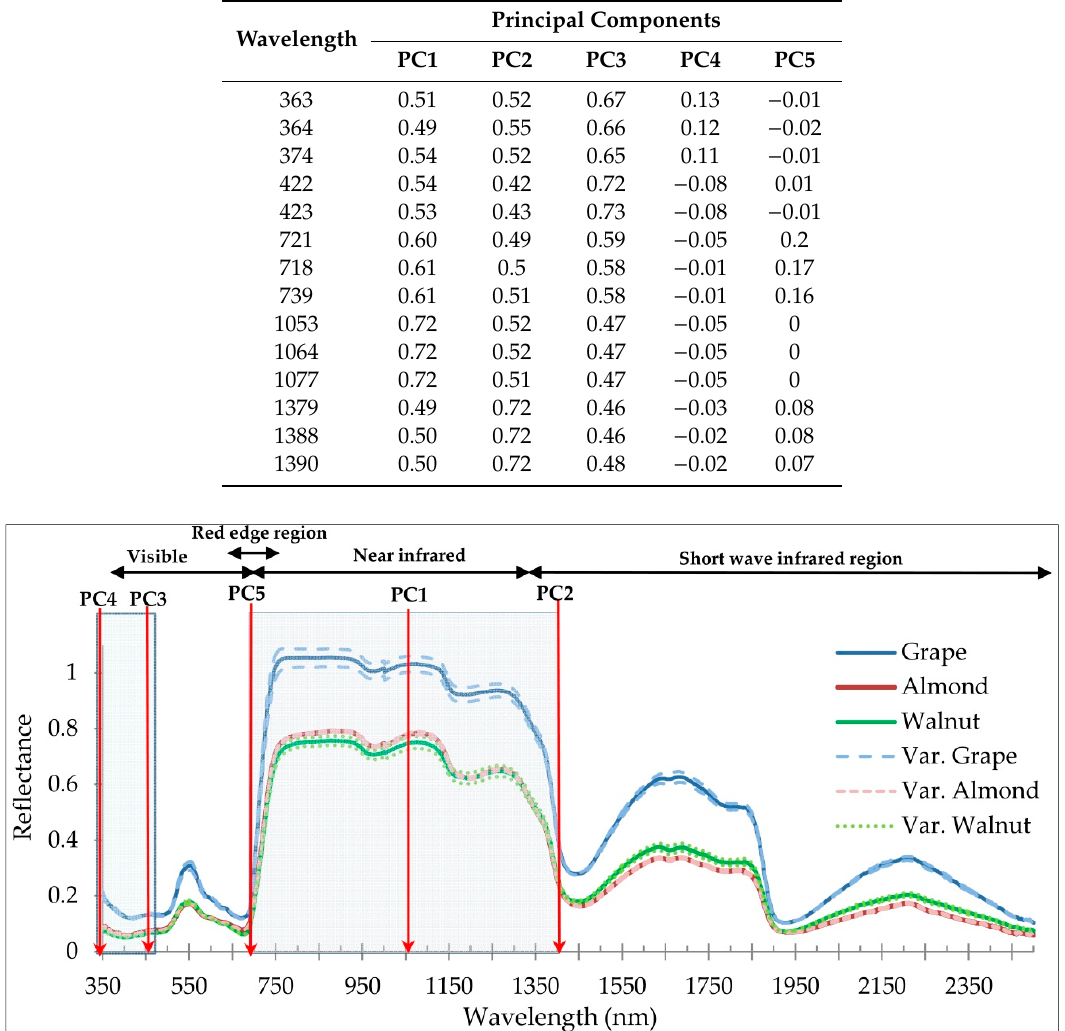
Figure 5. The position of five optimal/final wavelengths in the separation of walnut, almond, and grape species in the studied area , introduced by PCA (vertical axis: spectral reflectance, and horizontal axis: spectral wavelengths).